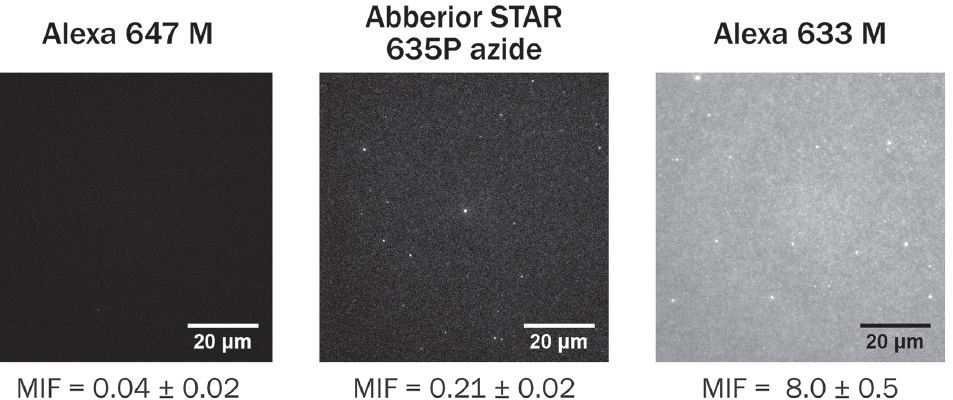
Figure 5. Observation of fluorophores interacting with lipid bilayers by fluorescence microscopy. After incubating a dye solution with a supported lipid bilayer and rinsing, any remaining fluorescence was imaged. The Alexa 647-M and Abberior STAR 635P azide images are set to the same contrast, while the Alexa 633-M sample was appreciably brighter.